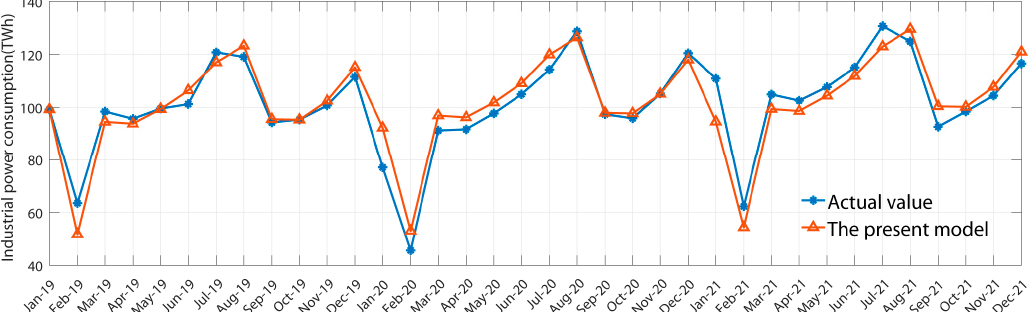
Figure 6. Comparison the simulation results with the actual values in 2019-2021